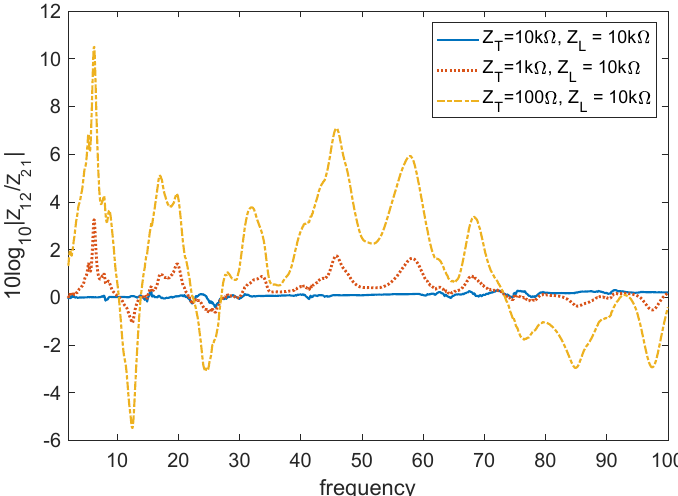
Figure 4. Symmetry of the trans-impedance Z for different values of Z T and Z L